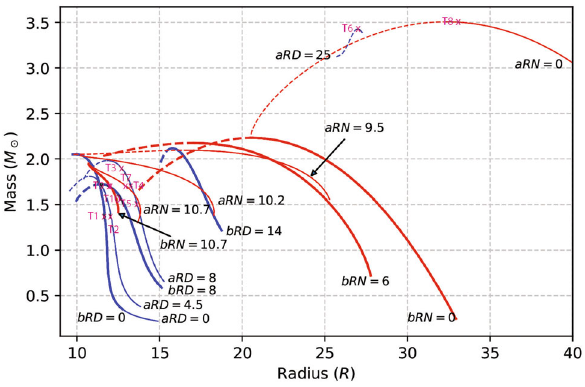
Fig. 3 Mass–radius relations for the hybrid stars of type (I) and (II) in Fig. 1, which are made of nuclear matter of SLy4 EoS and dark matter of EoS (1) with B = 0 . 035 or 0 . 055. With B = 0 . 035 these relations are labelled by aRN = r W (red) for the first scenario, by aRD = r W (blue) for the second. Similarly, with B = 0 . 055 they are labelled by bRN = r W (red) and bRD = r W (blue)). For example, aRD = 8 means the radius of dark core is 8 km, with B = 0 . 035. The unstable configurations are indicated by the parts of dashed lines. Note that r W is a parameter to characterize the model interaction between dark matter and baryons. The crosses labeled by T n indicate special stars mentioned later in Table 1